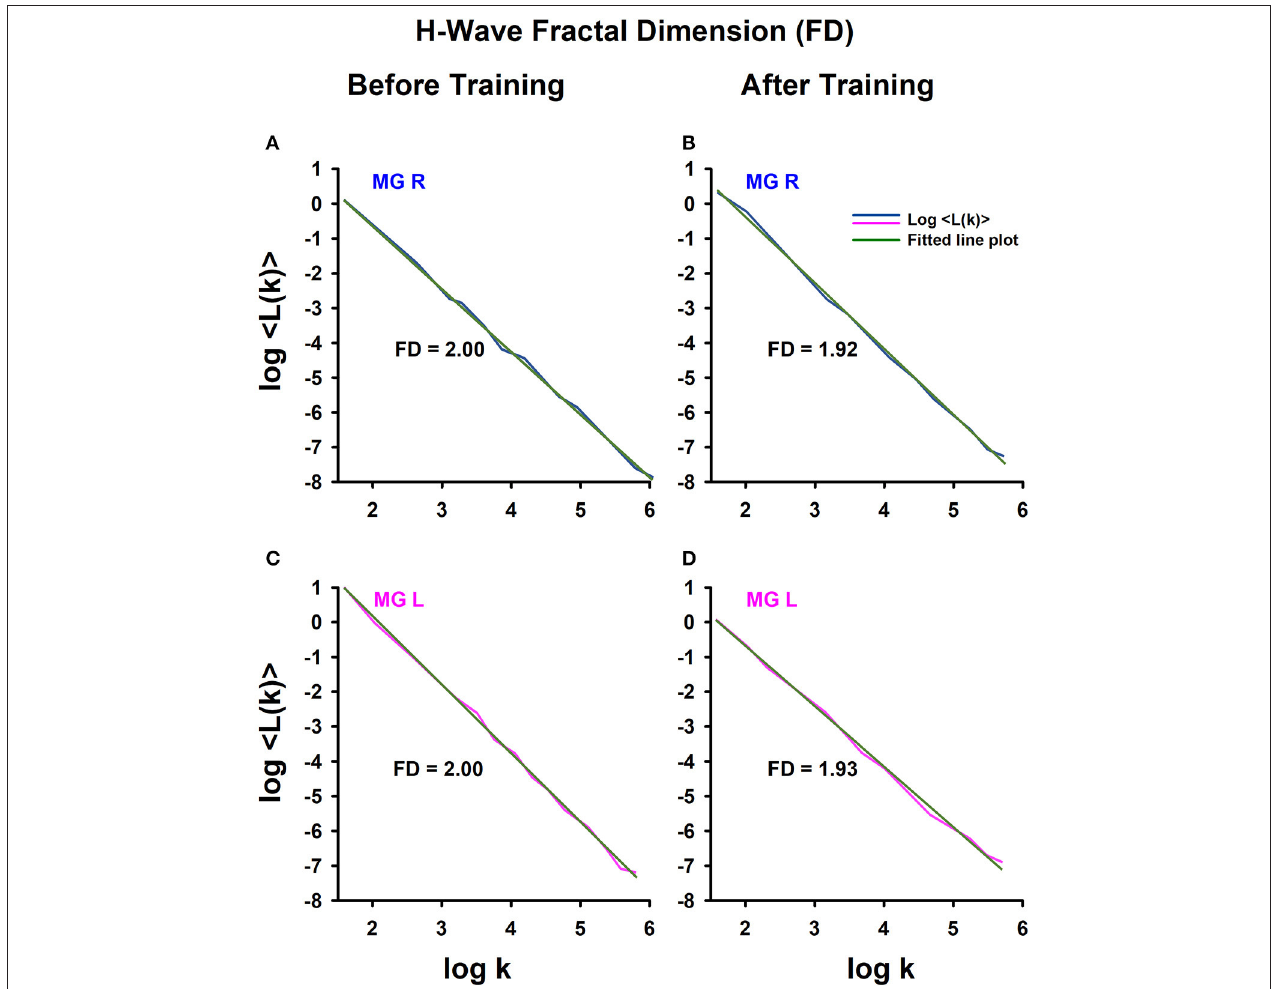
FIGURE 4 | H-wave fractal dimension (FD) computed with Higuchi’s method. (A) The FD was calculated from data: (A) before training and (B) after training. The MGL muscle responses are from: (C) before training and (D) after